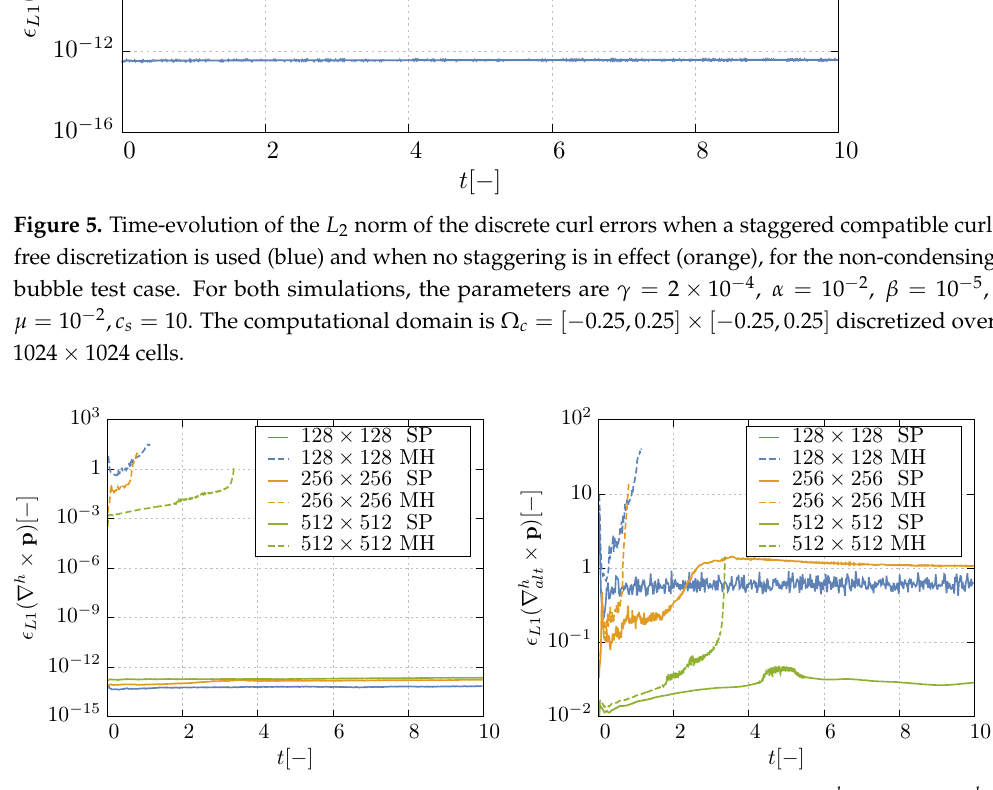
Figure 6. Time-evolution of the L 1 norm of the discrete curl errors, with both (right), when the structure-preserving (SP, continuous lines) staggered scheme is used versus a simple MUSCL-Hancock (MH, dashed lines) method, on different mesh sizes for the non-condensing bubble test case. The parameters are γ = 2 computational domain is Ω c = [